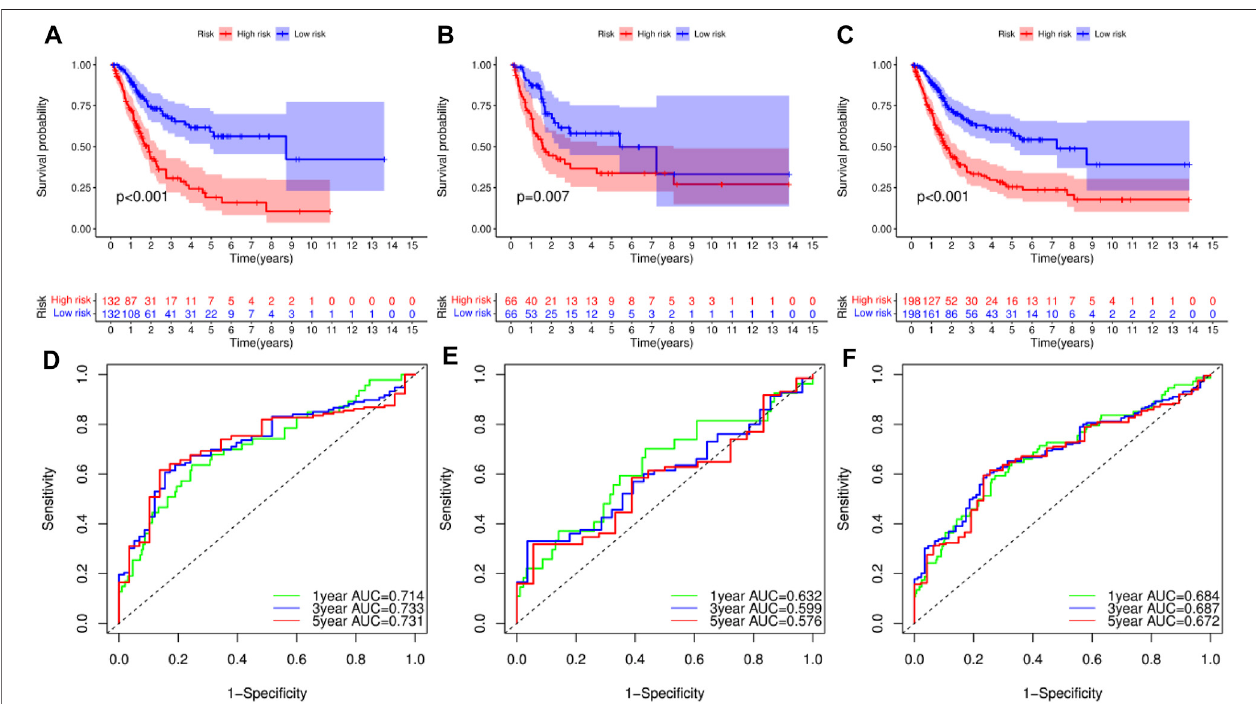
FIGURE 5 | Survival analysis of bladder urothelial carcinoma (BLCA) in different datasets and receiver operating characteristic (ROC) curve analysis for prognostic model. (A – C) Survival analysis of BLCA patients with high- and low-risk scores (RSs) in the training set, test set and combined set, respectively. (D – F) ROC curve analysis for the prognostic model at 1-, 3- and 5-years in the training set, test set and combined set,